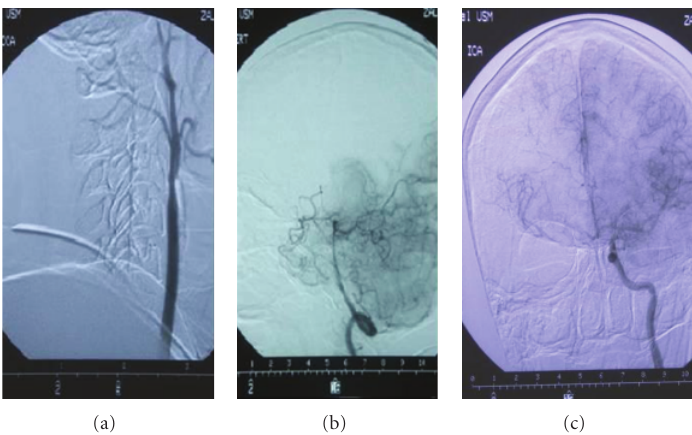
Figure 2: Digital subtraction angiography performed within 2 weeks of admission. The left-right common carotid artery lateral view was showing an absence of right internal carotid artery (ICA) branch (a). The middle-left vertebral artery lateral view was showing increased collaterals from posterior communicating artery (b). Finally the right-left ICA anterior view was showing a cross-supply of collaterals into the right ICA territory